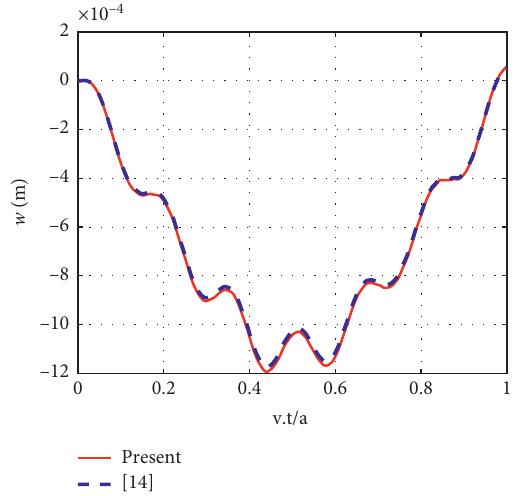
Figure 6: Dynamic deflections of the central point of the SSSS rectangular plate versus